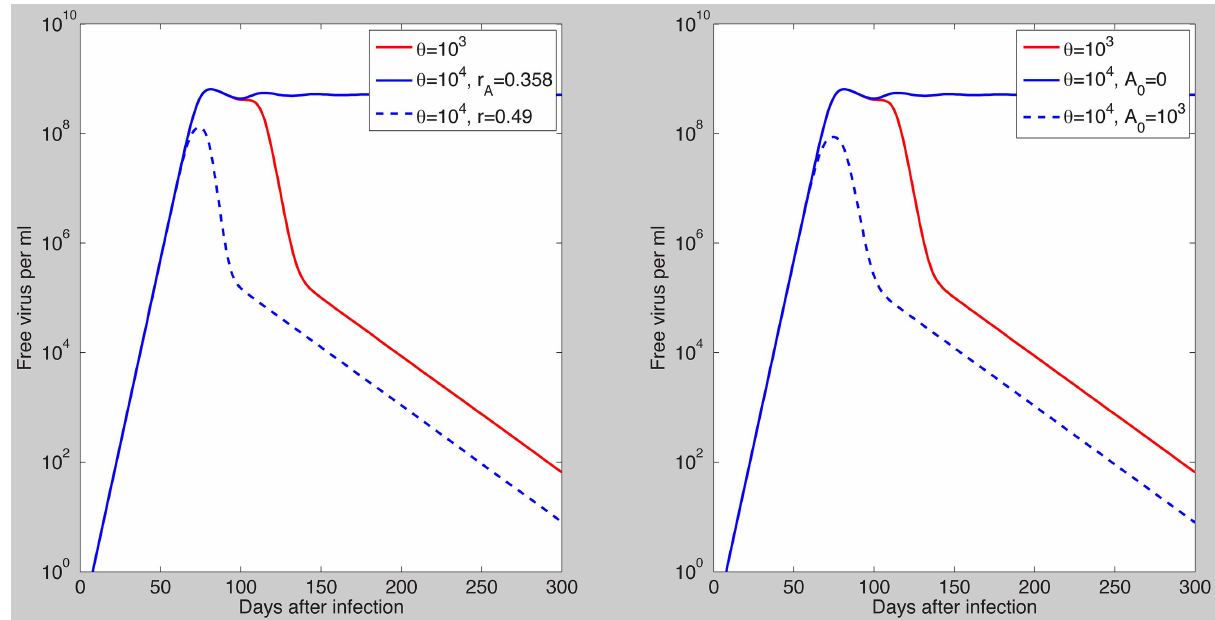
Figure 5. Free virus dynamics as given by model (7) and parameters in Tables 1 and 2 (median values): The asymptotically stable cleared infection steady state is approached for h ~ 10 3 (red line, both panels); bistable dynamics is observed for h ~ 10 4 with (left panel): Viral clearance for r A ~ 0 : 49 d { 1 and A 0 ~ 0 (dashed blue line) and viral persistence for r A ~ 0 : 358 d { 1 and A 0 ~ 0 (solid blue line); (right panel): Viral clearance is observed for r A ~ 0 : 358 d { 1 and A 0 ~ 10 3 molecules per ml (dashed blue line) and viral persistence for r A ~ 0 : 358 d { 1 and A 0 ~ 0 molecules per ml (solid blue line).